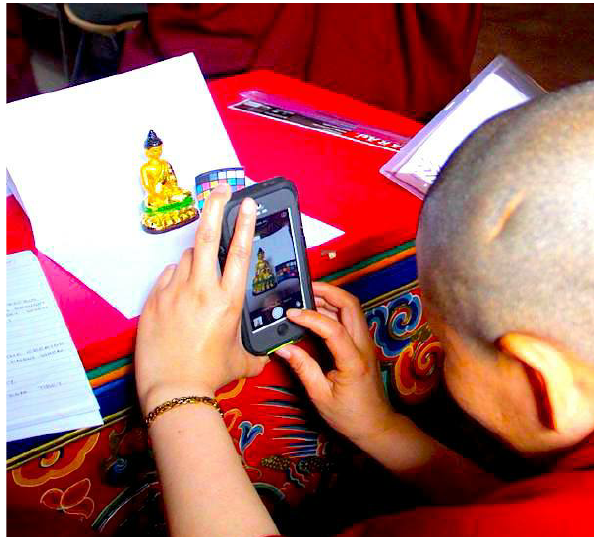
Figure 1. Nun learning digital documentation on her own mobile